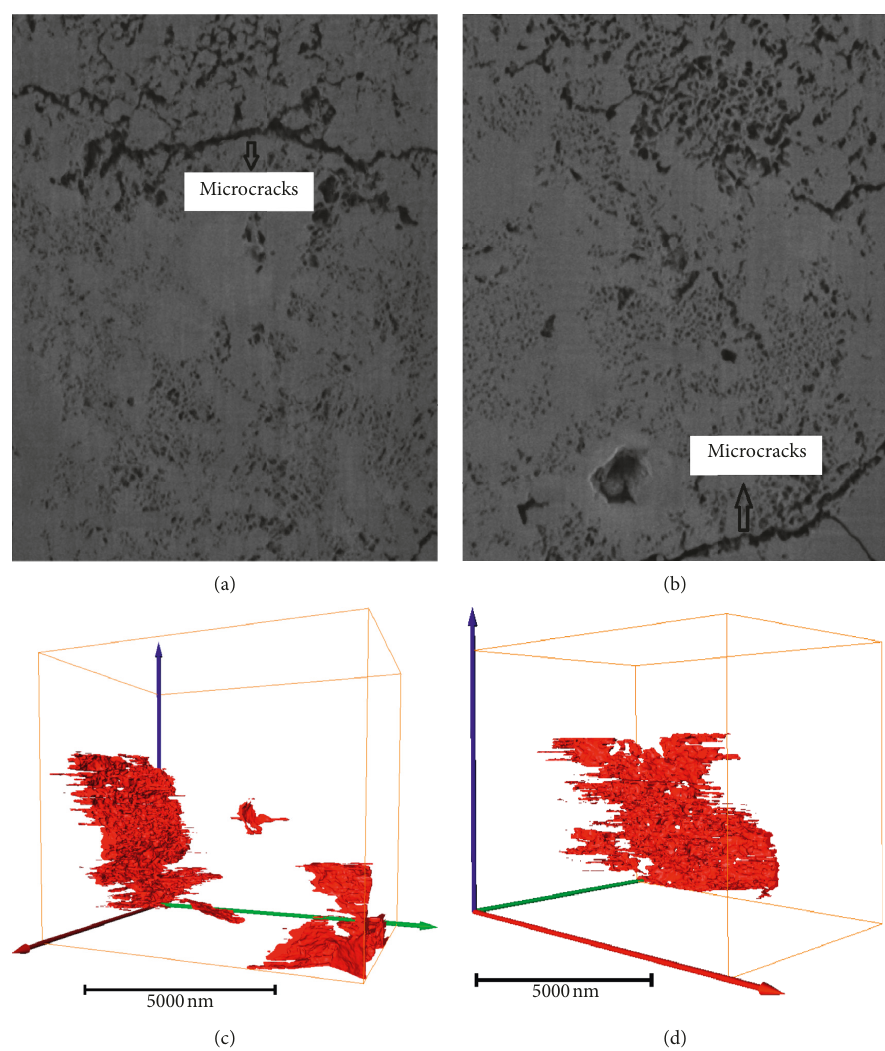
Figure 15: 2D surface and 3D volume of microcracks in FIB/SEM images: (a) microcracks in FS1 with a smooth surface; (b) microcracks in FS1 with a rough surface; (c) microcracks of FS1; (d) microcracks of